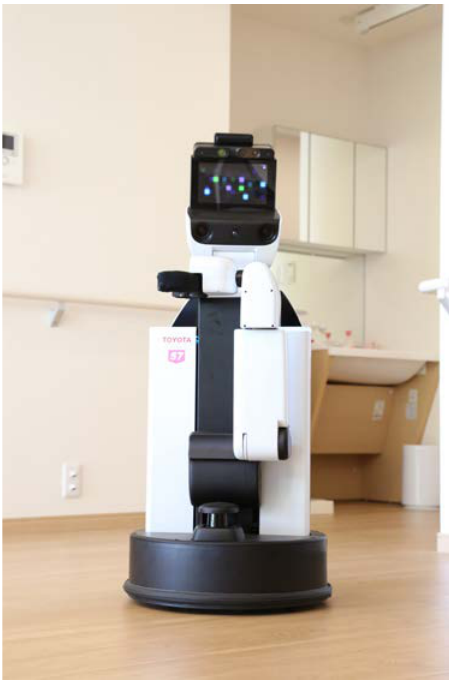
Figure 3 Example of an operational assist system (human support robot, Toyota Motor Corp.) This system works better with a combination of a robotic hand and an environmental control system. The robotic hand is used for